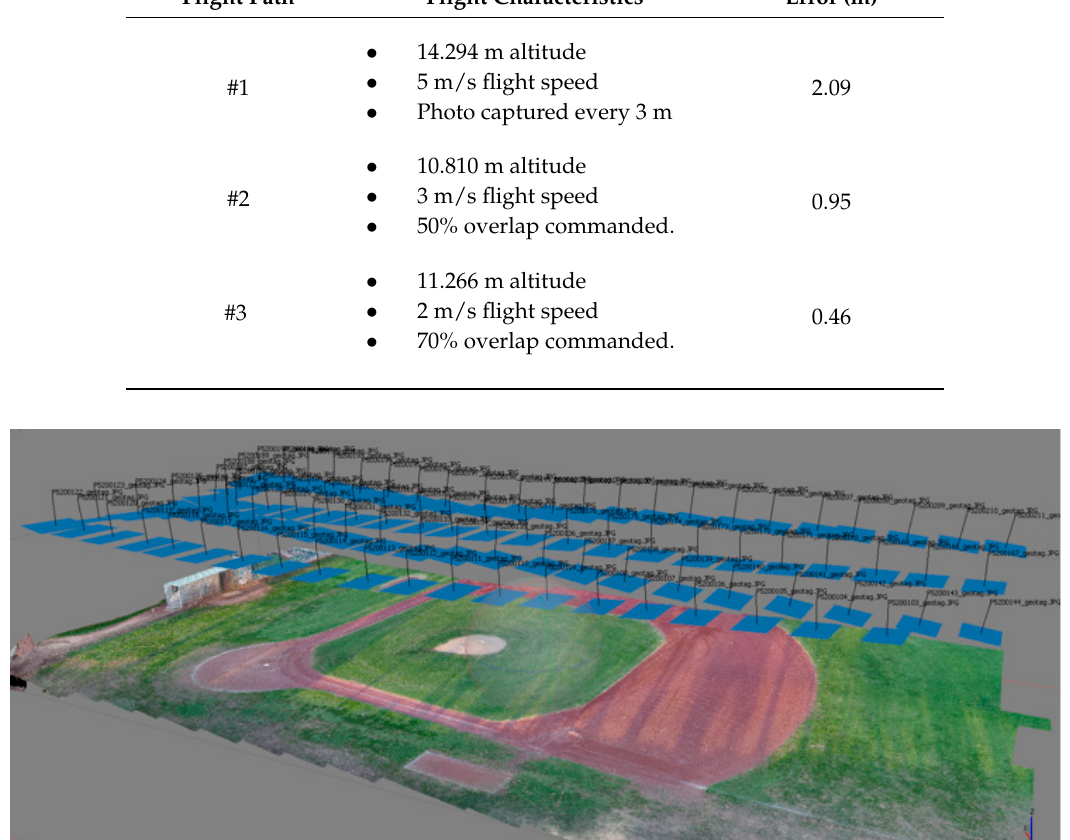
Table 1. Average error (adapted from Chiu et al. [14]).